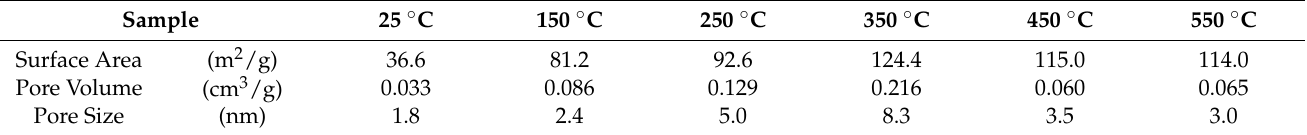
Table 1. BET surface area and pore characteristics of goethite and its calcined products at different